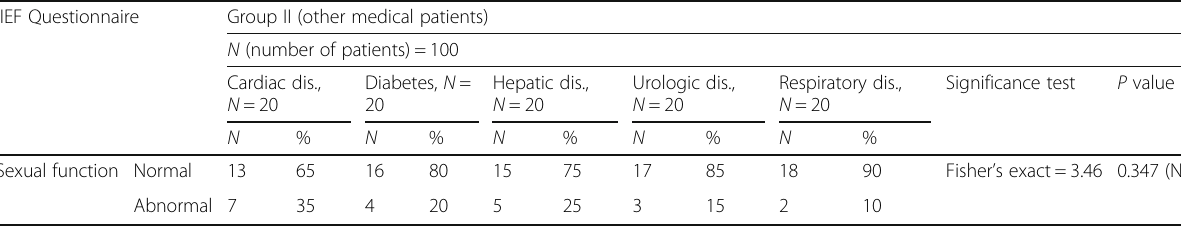
Table 4 Sexual dysfunctions among patients of group II (other medical